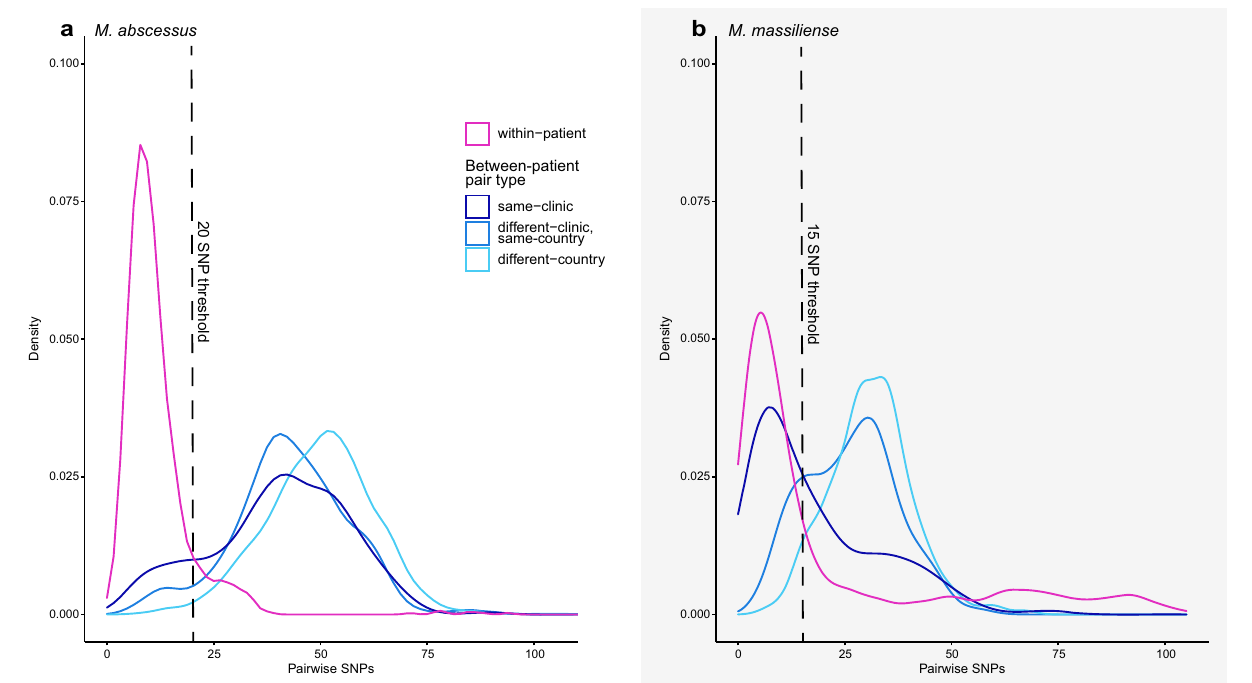
Fig. 2 Pairwise SNP differences were signi fi cantly lower for isolates from the same patient than for those from different patients. Distributions of pairwise SNPs from within-patient and between-patient isolates in a M. abscessus and b M. massiliense were used to calculate a SNP threshold for closely related isolates (Supplementary Fig. 3; Methods). Pairwise combinations of isolates from the Li dataset were removed from this fi gure, as we did not have information on the speci fi c clinic or province of origin for these isolates. Where data were available (for the Bryant dataset and the newly sequenced isolates), we also show the breakdown of between-patient isolates into same-clinic, different-clinic and same-country, and different-country